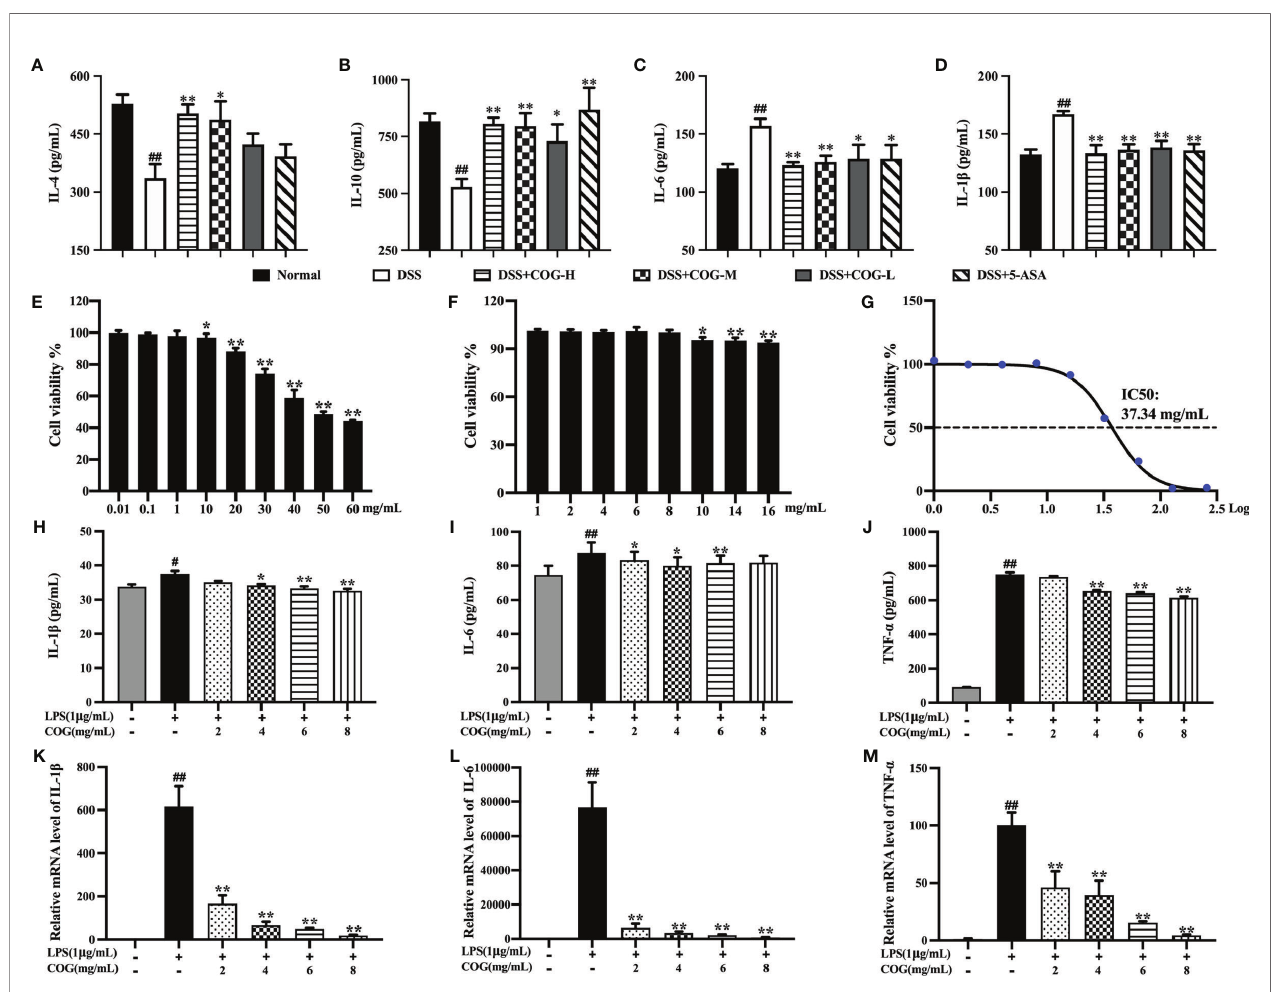
FIGURE 4 | Anti-in fl ammatory effects of COG in vivo and in vitro . Cytokine levels of (A) IL-4, (B) IL-10, (C) IL-6, and (D) IL-1 b in mice colon. (E, F) Cell viability of COG on RAW264.7 cells. (G) IC 50 of COG on RAW264.7 cells. In fl ammatory cytokine secretion levels of (H) IL-1 b , (I) IL-6, and (J) TNF- a on RAW264.7 cells. The relative mRNA expression levels of (K) IL-1 b , (L) IL-6, and (M) TNF- a on RAW264.7 cells. Data were presented as mean ± SEM ( n = 6 – 12). # p < 0.05 and ## p < 0.01 compared to the normal group; * p < 0.05 and ** p < 0.01 compared to the DSS or LPS